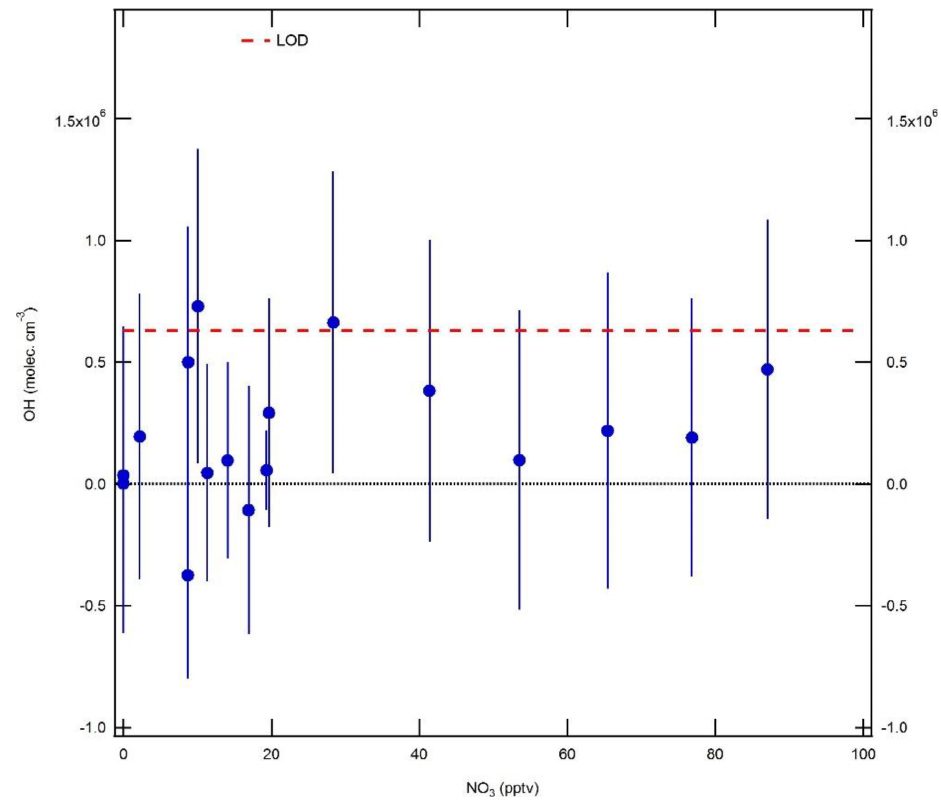
Figure 9. Equivalent OH concentrations ( ± 1 σ ) measured during NO 3 radical interference tests. NO 3 concentrations were calculated using a box model, and OH interference signals were corrected for the interference from O 3 + H 2 O. The OH limit of detection (LOD, 6 . 3 × 10 5 molec.cm − 3 , SNR = 2) is denoted by the dashed red